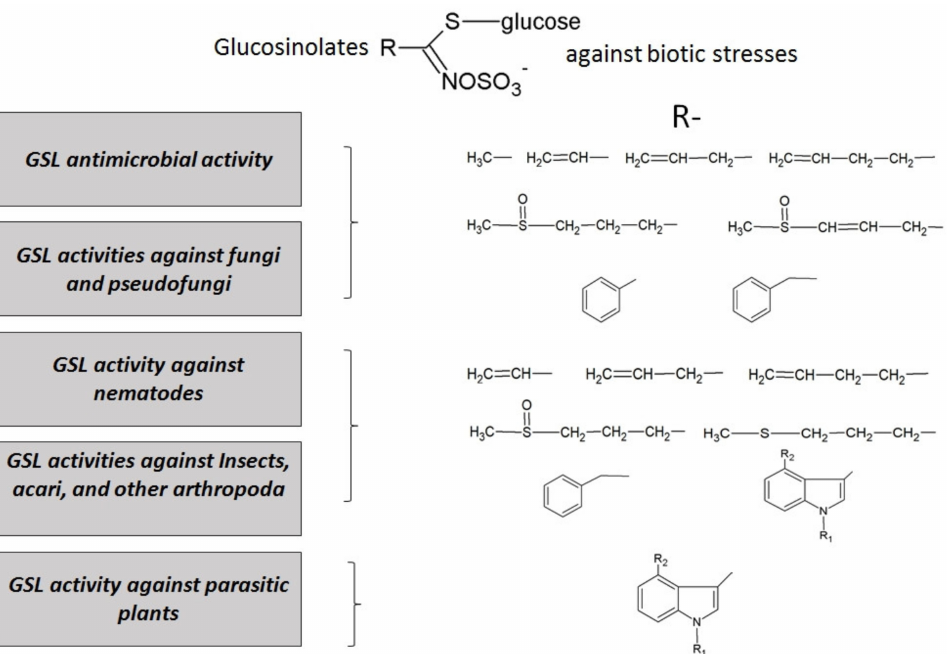
Figure 4. Main activities of glucosinolates and their hydrolysis products against biotic stresses in plant protection. The side chains (R) of glucosinolates, studied to date for each effect, have also been